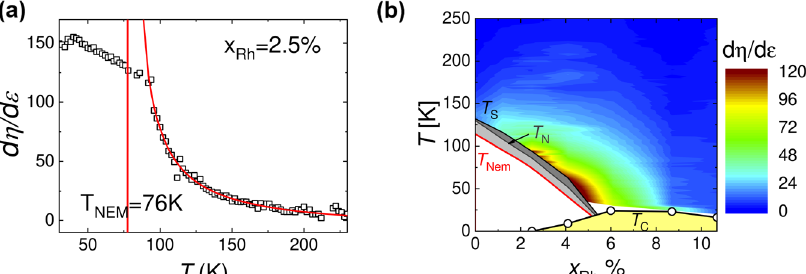
Fig. 9 Elastoresistivity measurements. Elastoresistivity of the Ba(Fe 1 − x Rh x ) 2 As 2 series. a Temperature-dependence of the strain ( ϵ ) derivative of the relative variation of the resistivity ( η = Δ ρ / ρ ) for a sample with x = 0.025. The red curves show the Curie-Weiss fi t in the nematic fl uctuation regime above the structural transition. b Phase diagram of the nematic susceptibility of the Ba(Fe 1 − x Rh x ) 2 As 2 series. T C , T N , T S , and T Nem represent the superconducting, the magnetic, the structural, and the nematic critical temperature, respectively. The colour scale reproduces the magnitude of d η /d ϵ , while the light yellow region corresponds to the superconducting